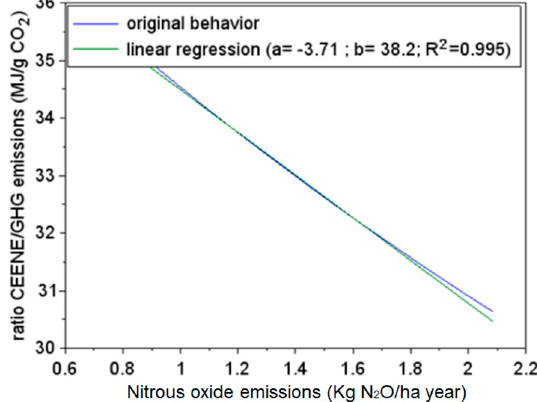
Figure 11. Y function behavior for nitrogen fertilization (50% to 150%).